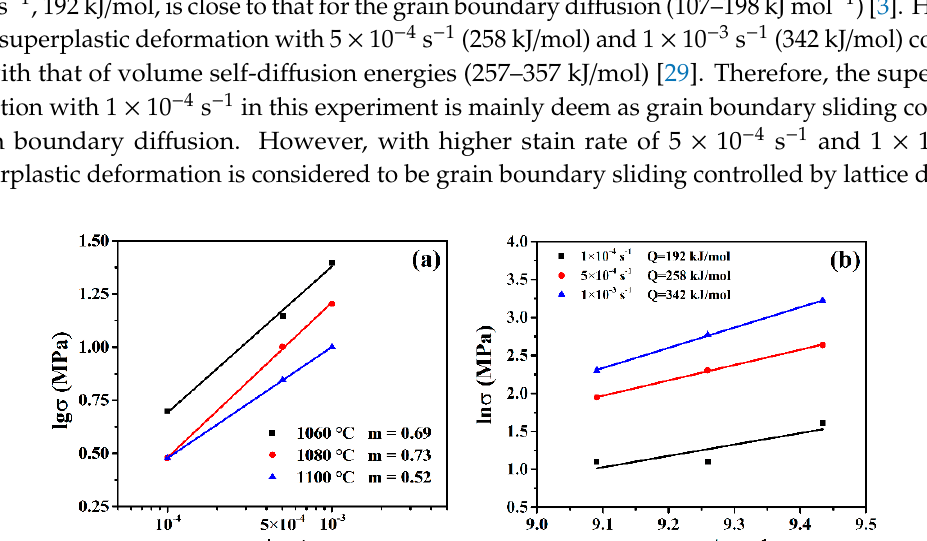
Figure 5. The superplastic tensile ductility to failure as a function of various initial strain rates at test temperatures.